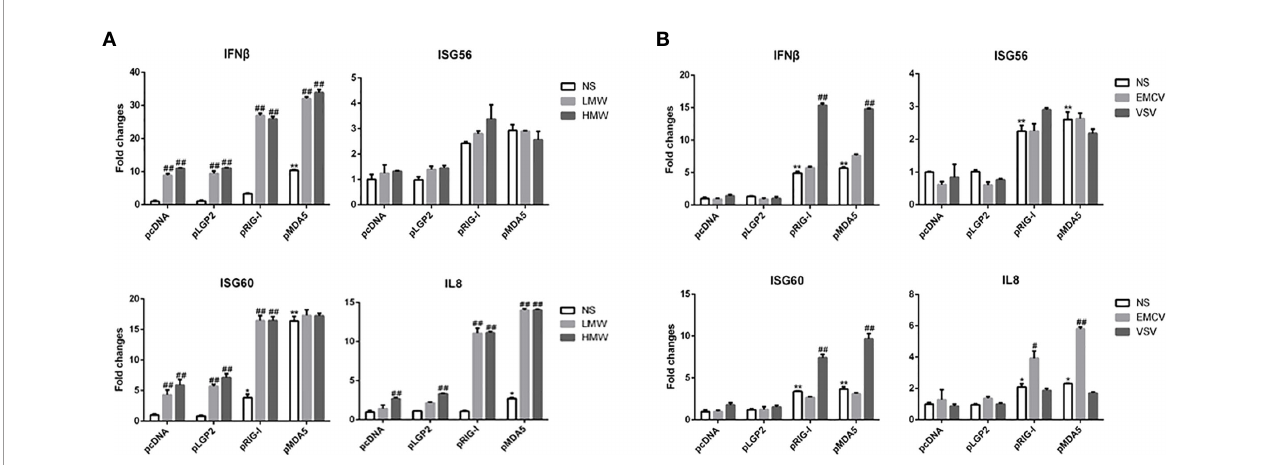
FIGURE 2 | The signal activity of pLGP2, pRIG-I and pMDA5 before and after poly I:C transfection and virus infection. (A) 293T cells grown in 24-well plates (3×10 5 cells/well) were transfected with HA tagged pLGP2, pRIG-I, pMDA5 or pcDNA (0.5 m g each) using Lipofectamine 2000. Twenty-four hours post transfection, the cells were transfected with LMW poly I:C or HMW poly I:C (1 m g/ml) for 8h stimulation. The harvested cells were analyzed by RT-qPCR for downstream gene expressions as indicated. (B) 293T cells in 24-well plates (3×10 5 cells/well) were transfected as in (A) and infected with 0.01 MOI EMCV or VSV for 8 h, and analyzed